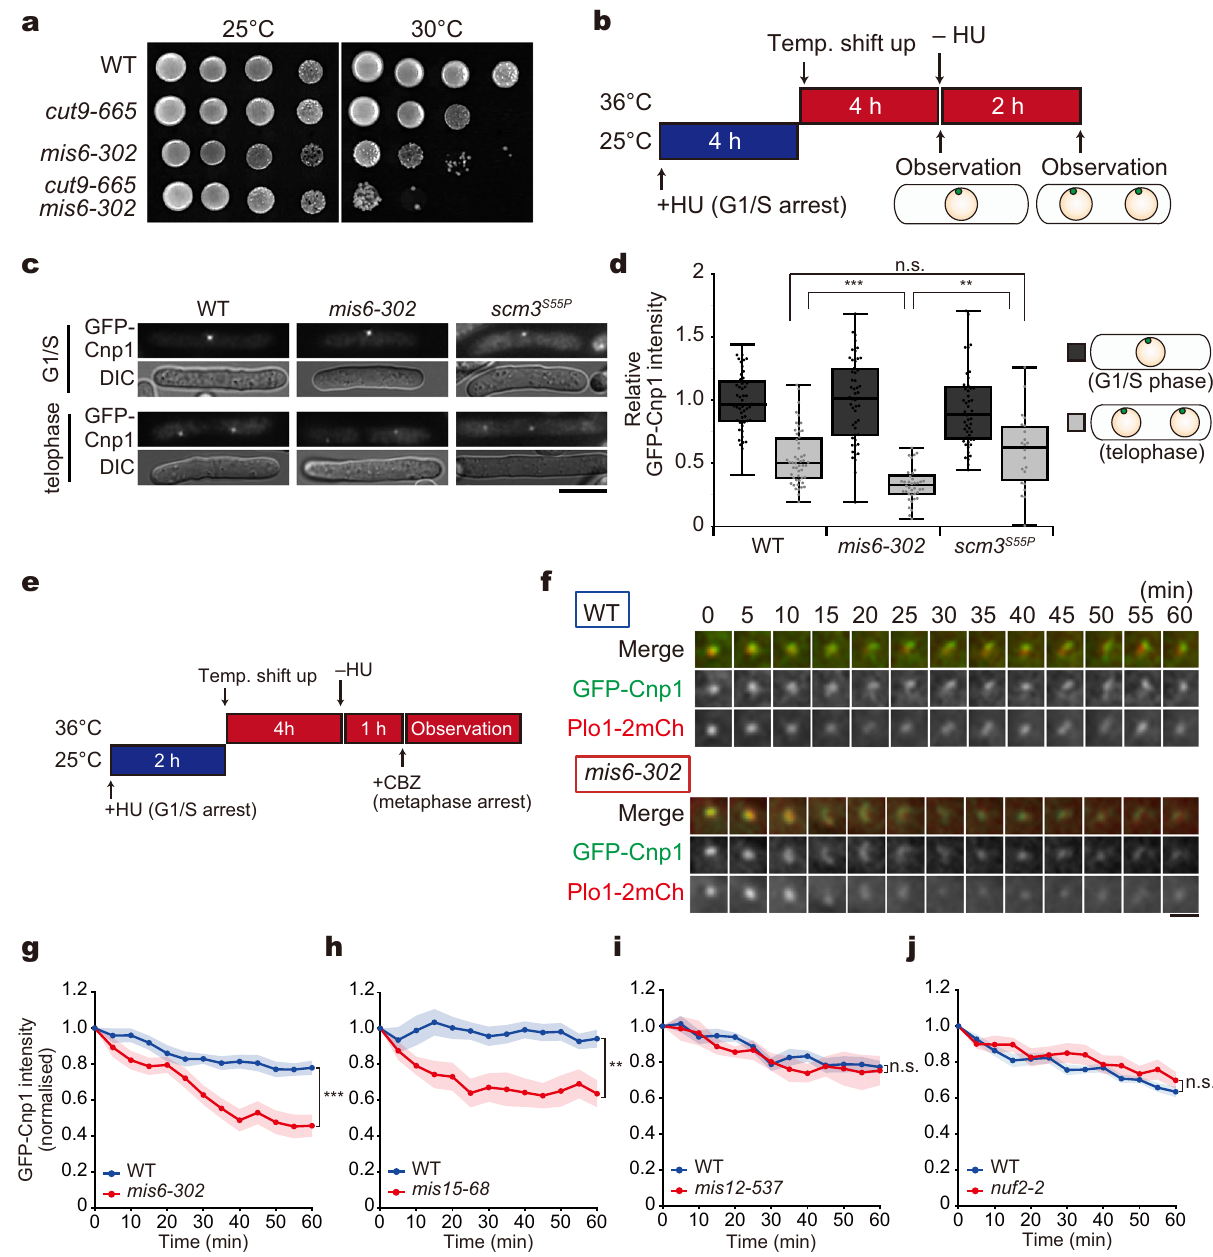
Fig. 2 Mis6 is required for Cnp1 maintenance at the centromere during metaphase. a Growth assays for indicated strains. Ten-fold serial dilutions of cells were grown at 25 and 30 °C. b – d Comparison of GFP-Cnp1 signals before and after mitosis. b Experimental design. Cells were synchronised at G1/S using hydroxyurea (HU) at 25 °C, followed by a shift up to the restrictive temperature (36 °C) for mis6-302 and scm3 S55P mutants in advance. The cells were then released to late mitosis via hydroxyurea (HU) removal. c Representative images showing GFP-Cnp1 and DIC before (G1/S) and after release from hydroxyurea (telophase) in WT, mis6-302 , and scm3 S55P cells. Scale bar = 5 µ m. d GFP-Cnp1 intensities during G1/S (black boxes) and telophase (grey